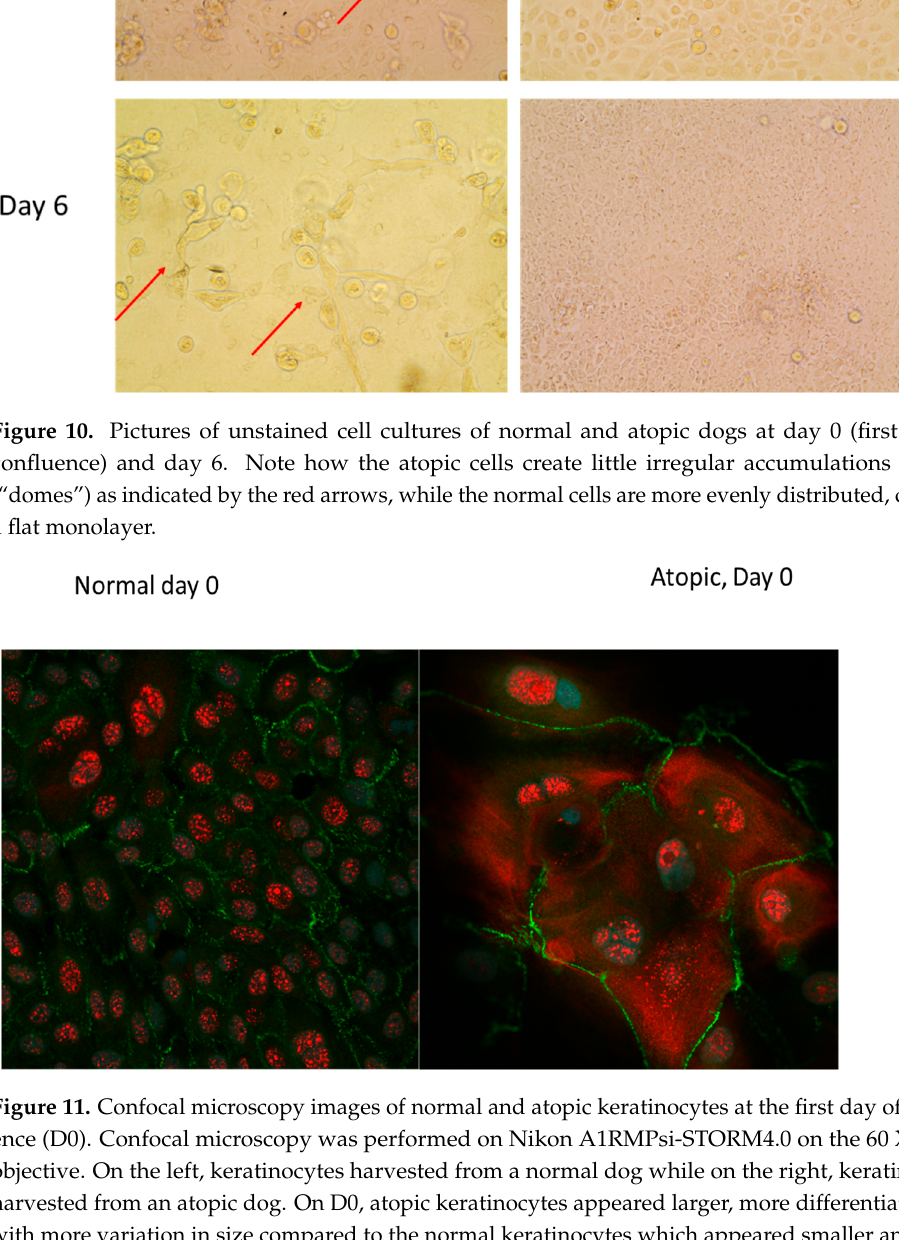
Figure 10. Pictures of unstained cell cultures of normal and atopic dogs at day 0 (first day of conflu- ence) and day 6. Note how the atopic cells create little irregular accumulations of cells (“domes”) as indicated by the red arrows, while the normal cells are more evenly distributed, creating a flat mon- olayer.